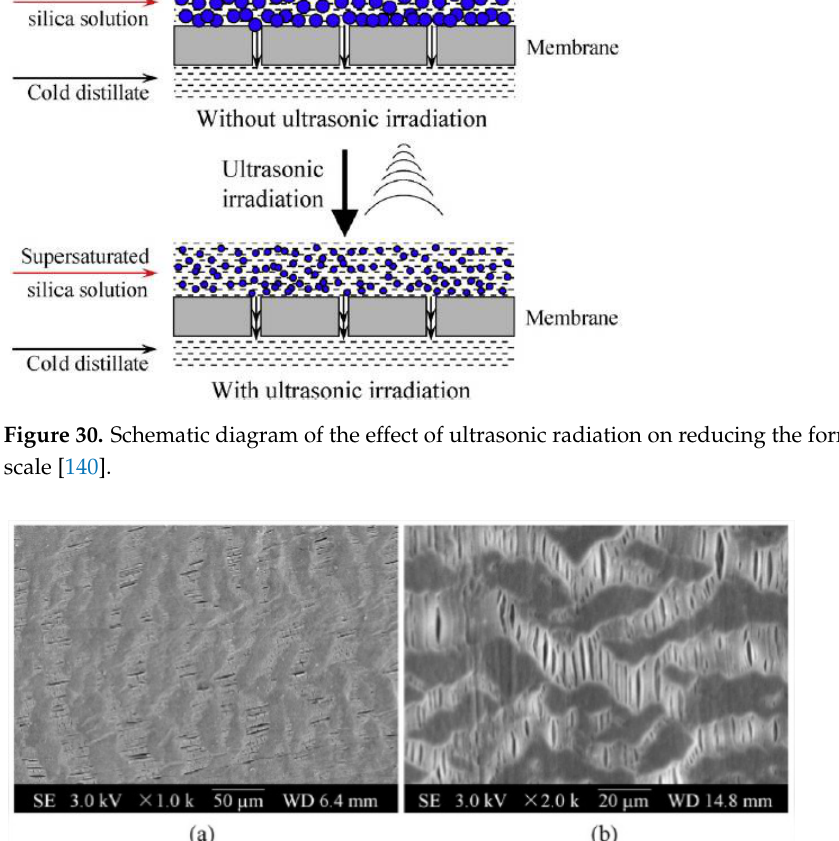
Figure 30. Schematic diagram of the effect of ultrasonic radiation on reducing the formation of silica scale [140]. Figure 31. Morphological images of the PTFE membrane after being irradiated with an ultrasonically concentrated silica solution: ( a ) 1000×; ( b ) 2000× [140].